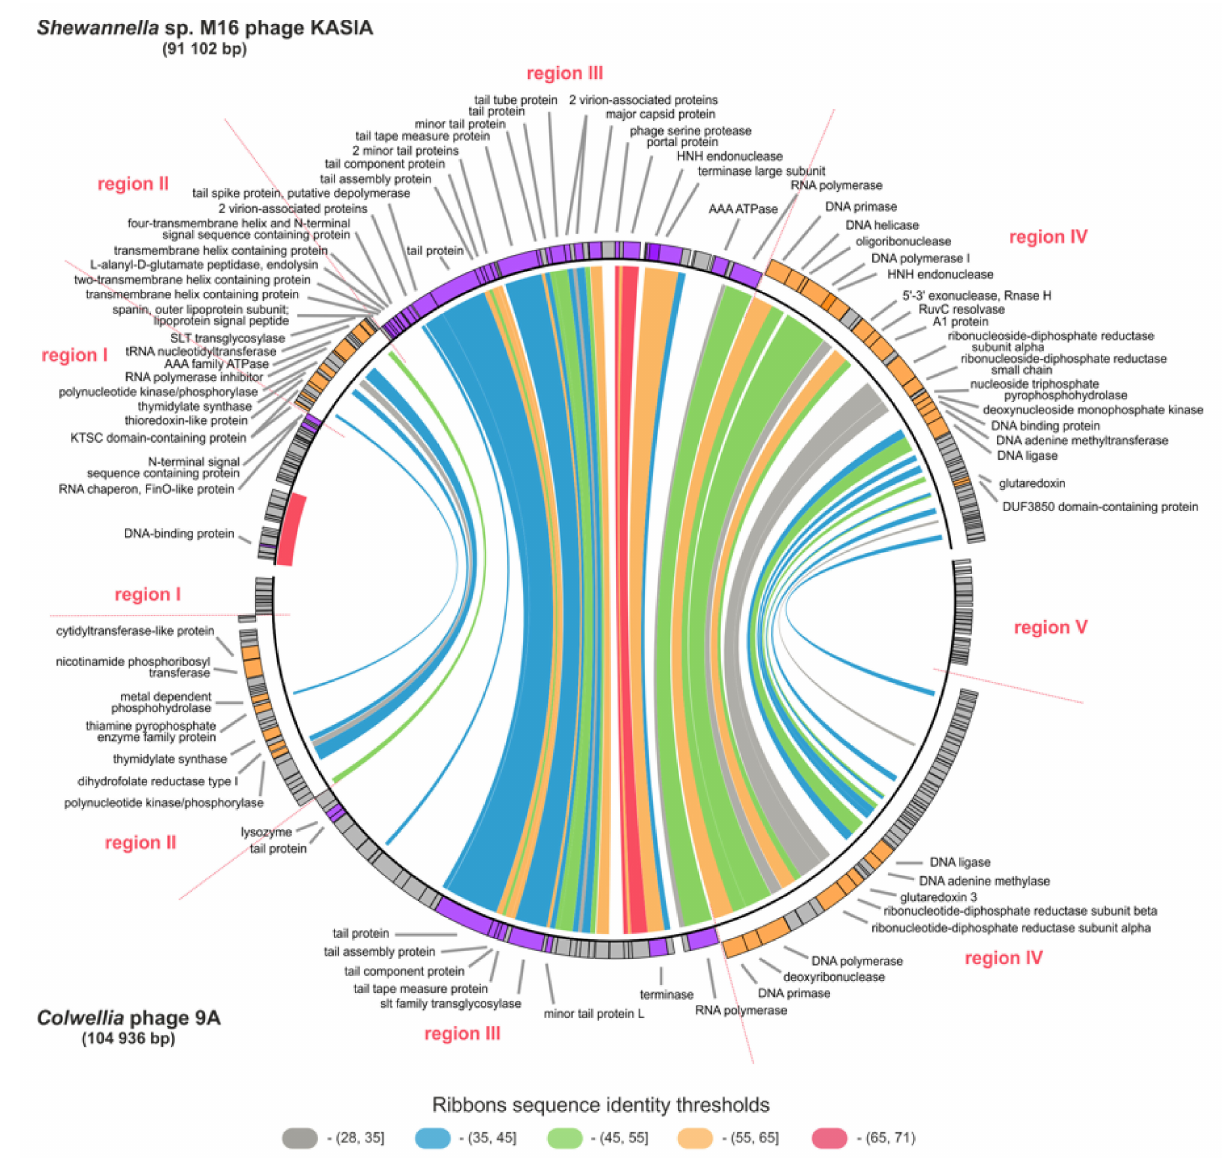
Figure 2. Comparison of the KASIA phage with Colwellia phage 9A. The similarities were based on all-against-all blastp searches, and are reflected by the ribbons connecting the ideograms. Their colors reflect the scale of the similarity between the encoded proteins, as indicated in the legend. The anchors of the ribbons correspond to the location of the protein-coding